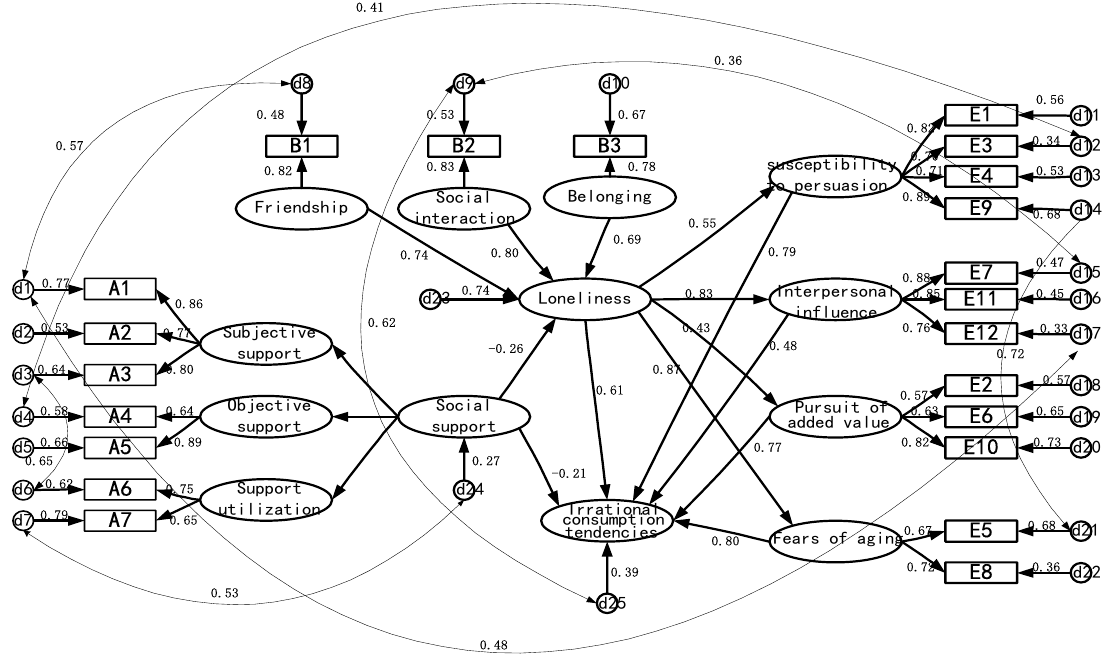
Figure 2. Structural equation model of social support, loneliness, and irrational consumption